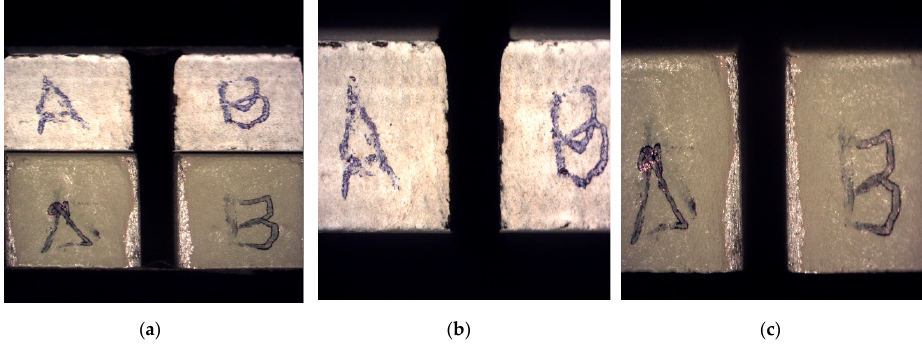
Figure 5. SOM image of the cutting front in: ( a ) Stack CFRP/UNS A97075; ( b ) CFRP plate; ( c ) UNS A97075 plate.